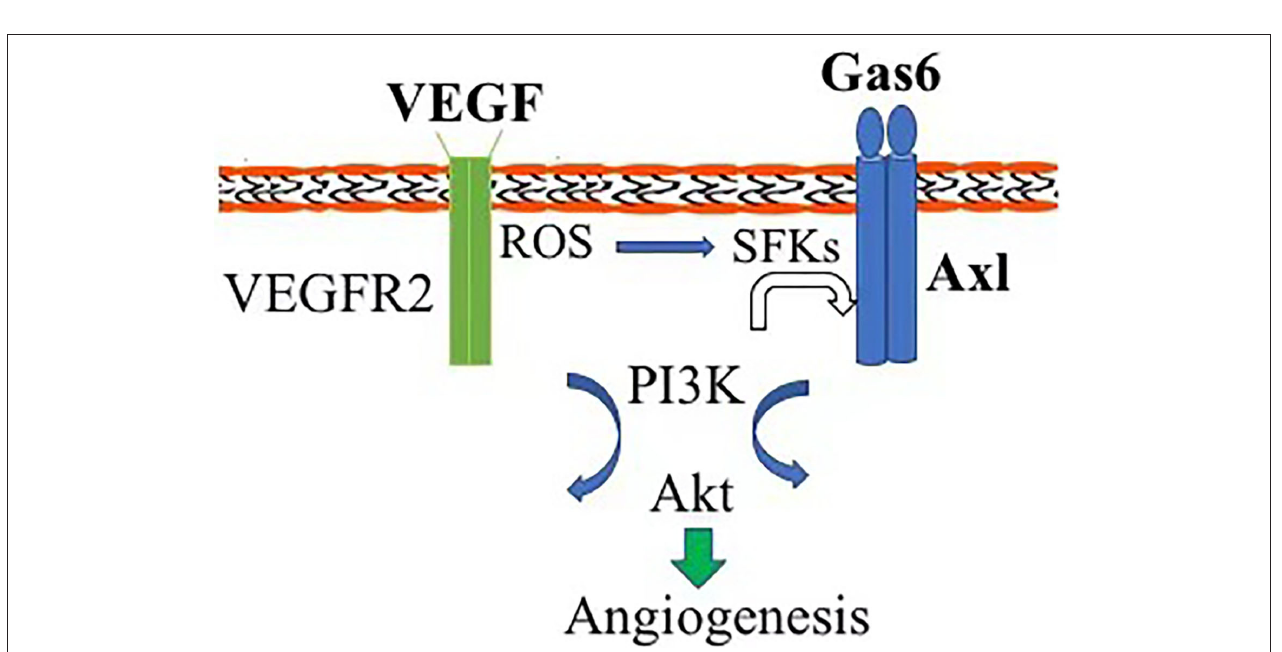
FIGURE 4 | Ki67 staining, scale bar: 1,000 µ m (C) . Bar graphs in (B) show the mean ± SD from five independent experiments. (D,E) A wound healing assay of migration of HRECs induced by PDR vitreous supplemented with R428 (4 µ M). (D) Representative of the photographed wound, scale bar: 400 µ m; (E) Bar graphs show the mean ± SD from five representative figures. (F,G) A matrigel assay of HRECs induced by PDR vitreous supplemented with R428 (4 µ M). (F) Representative photos, scale bar: 400 µ m; (G) Bar graphs of tube lengths in five representative photos of three independent experiments. ****means the difference was significant and p < 0.0001.